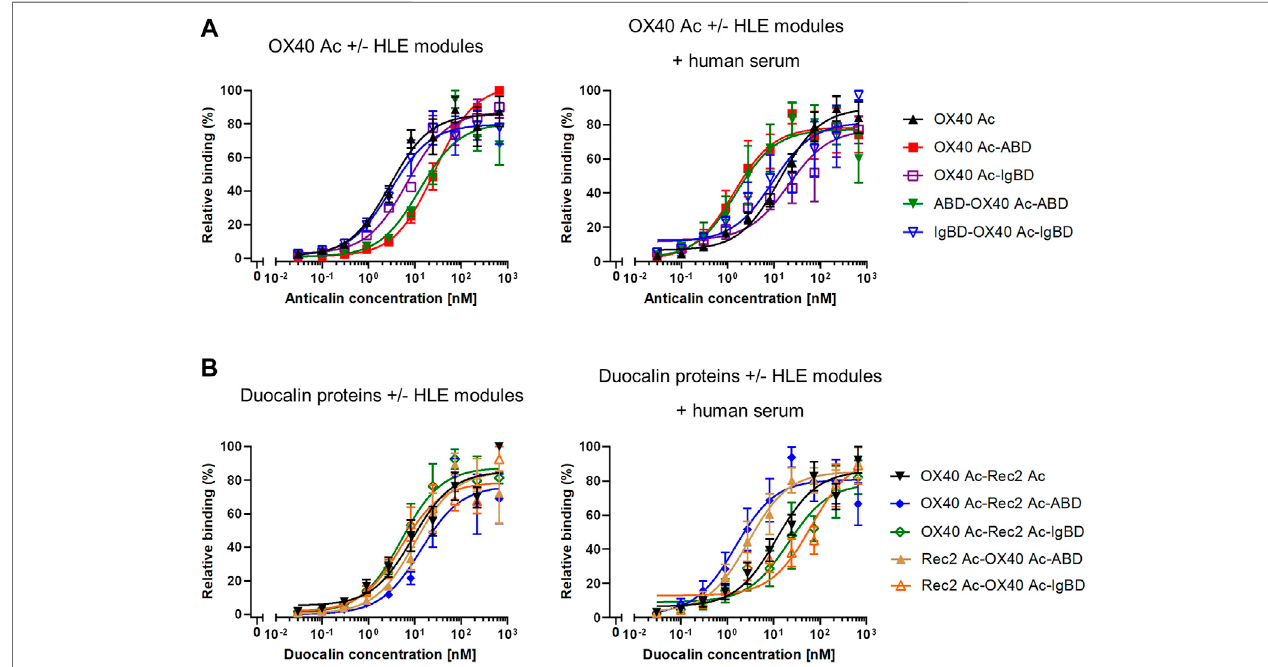
FIGURE3 | Binding ofAnticalin proteins to OX40 receptor expressed on CHO cells. (A) OX40-speci fi cAnticalin proteinsor (B) Duocalinproteins speci fi c forOX40 and a second TNFRSF receptor were analyzed for binding to Flp-In-CHO:huOX40 cells in fl ow cytometry in absence (left diagrams) or presence of 2% human serum (rightdiagrams) .Normalizationofdatawasdonebysettingthehighest fl uorescencevalueineachsampletitrationrowto100%andthe fl uorescenceofthecellcontrol to 0%. Data is represented as mean ± S.E.M. (standard error of the mean) of normalized datasets from four experiments.